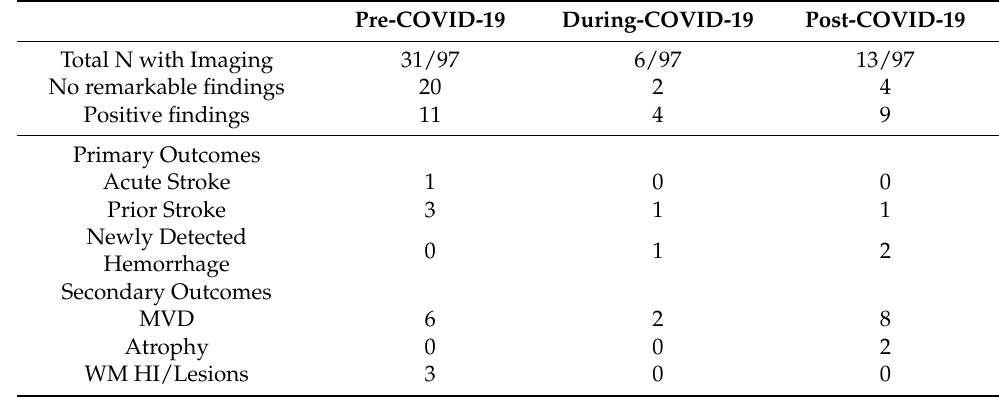
Table 4. Major brain imaging findings pre-, during and post-COVID-19 diagnosis.